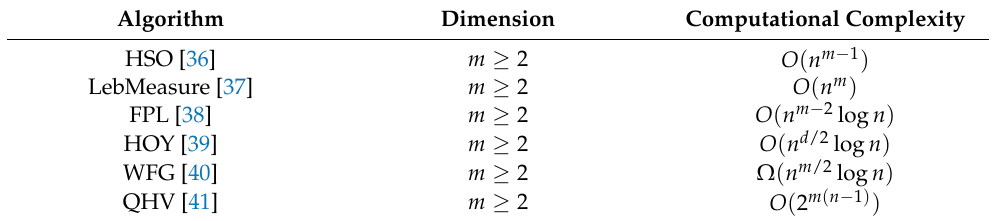
Table 1. Algorithms for the exact hypervolume computation on an m -dimensional set of n points.